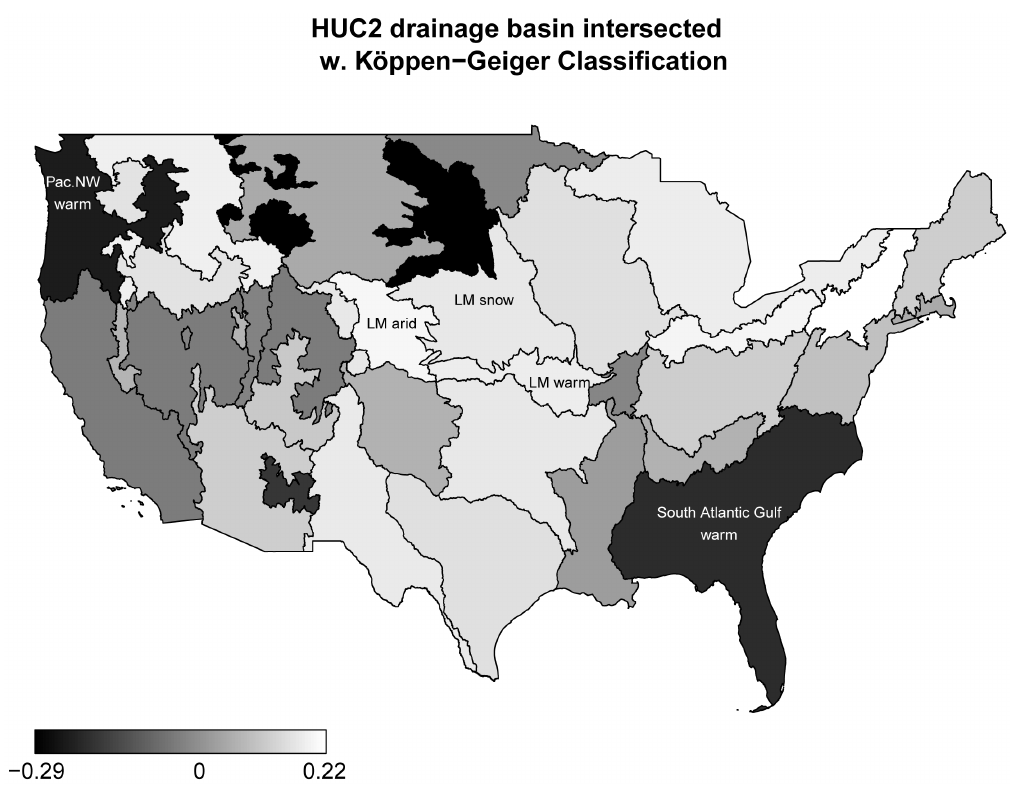
Figure 11. Effects of basin-climate regions. Estimated effects of basin-climate regions on EPHEptax, as obtained from applying boosted beta regression to 100 bootstrap samples of the NLA data. The figure presents median effect estimates for the mean parameter m computed from the 100 model fits (LM=Lower Missouri).